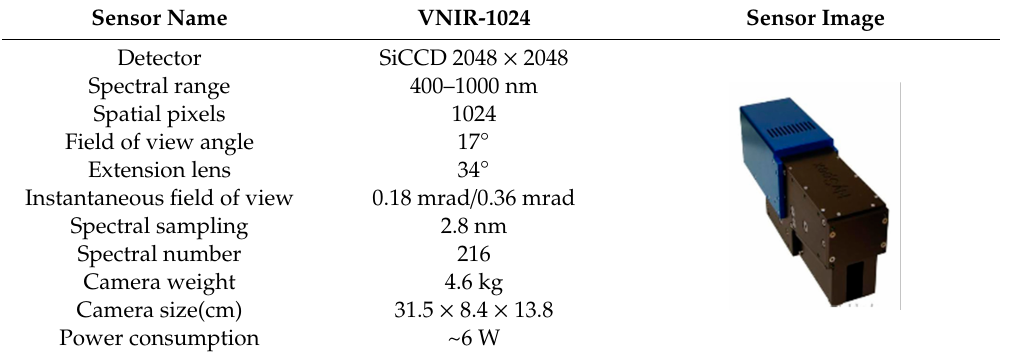
Table 1. Main parameters of HySpex imaging